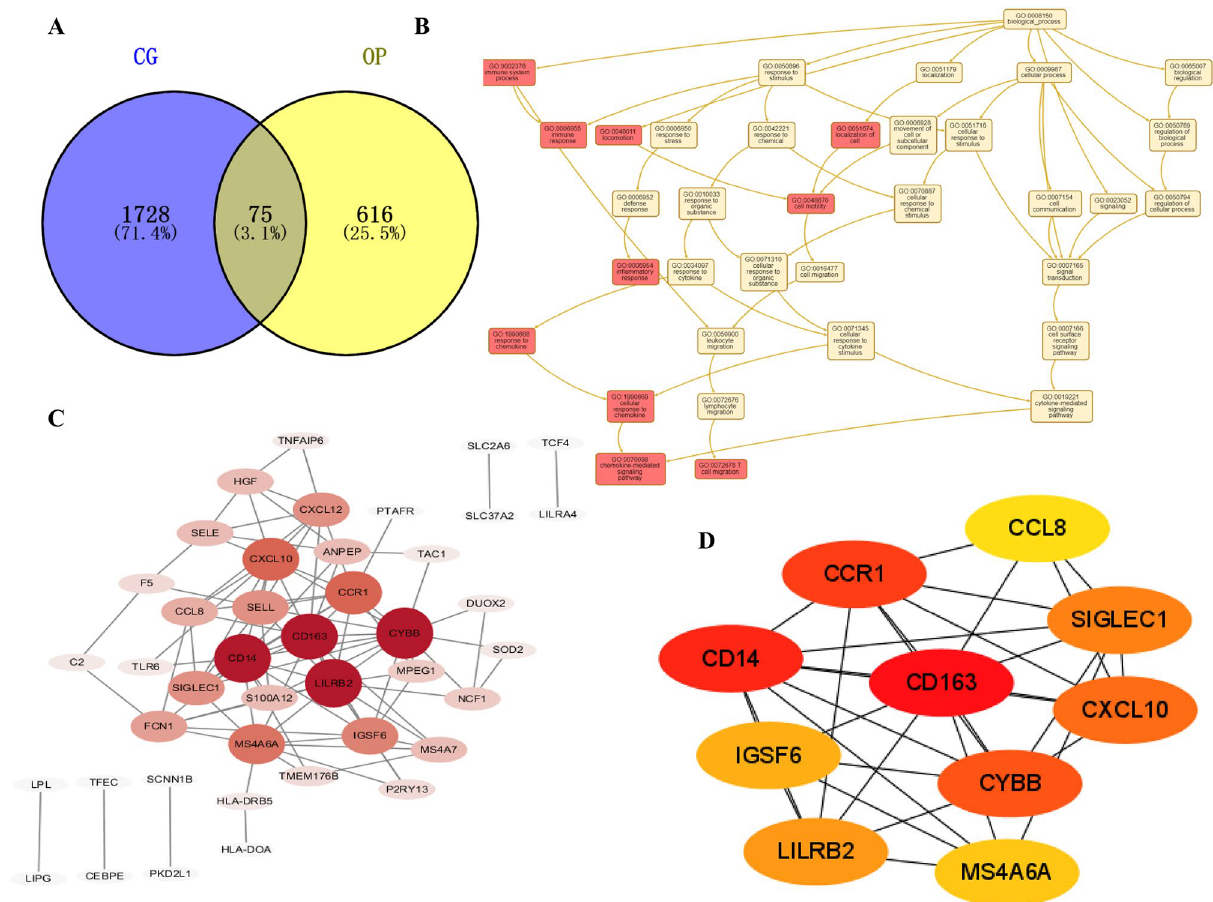
Figure 5. Venn diagram of CG-OP intersection targets ( A ), DAG ( B ), PPI network and topology analysis ( C , D ), GO functional enrichment analysis ( E ), KEGG enrichment analysis of signaling pathways ( F , G